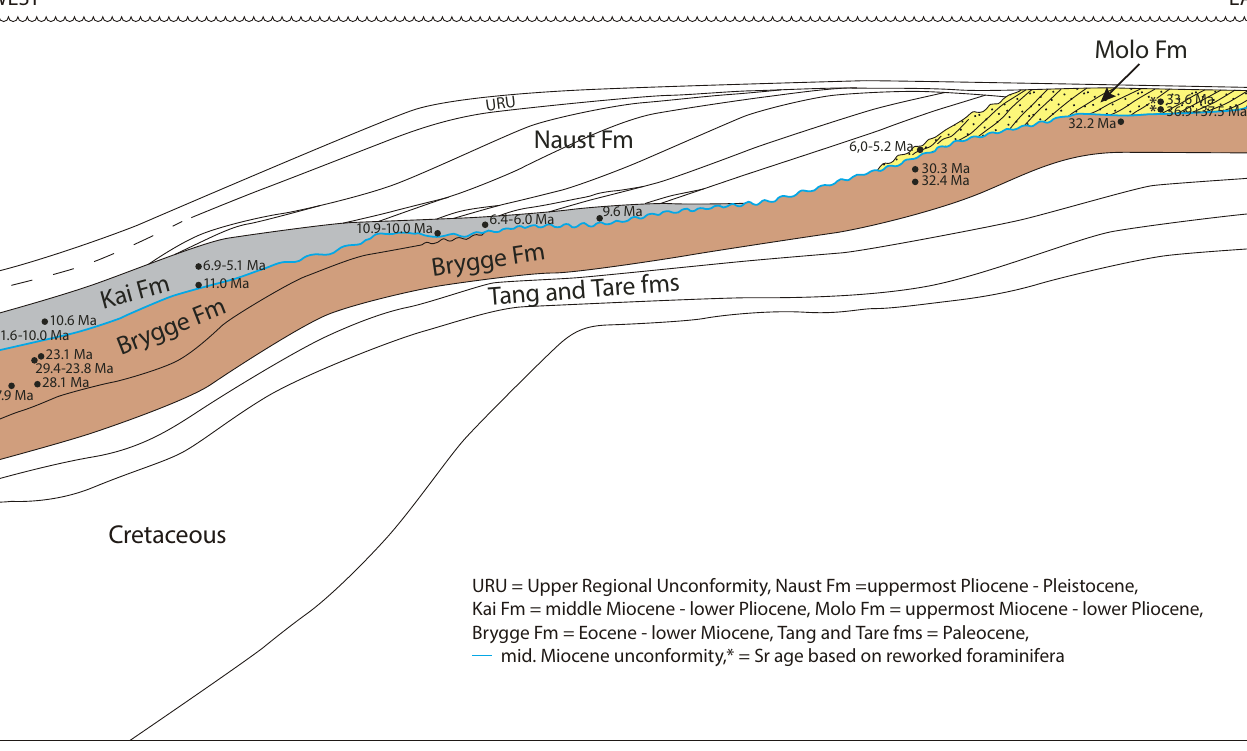
Figure 73. Schematic and generalised cross-section of the Norwegian Sea shelf (modified after Henriksen et al., 2005; Eidvin et al., 2013d) including main ages obtained from strontium isotope analyses based on fossil tests interpreted to be in situ (except in the proximal (eastern) part of the Molo